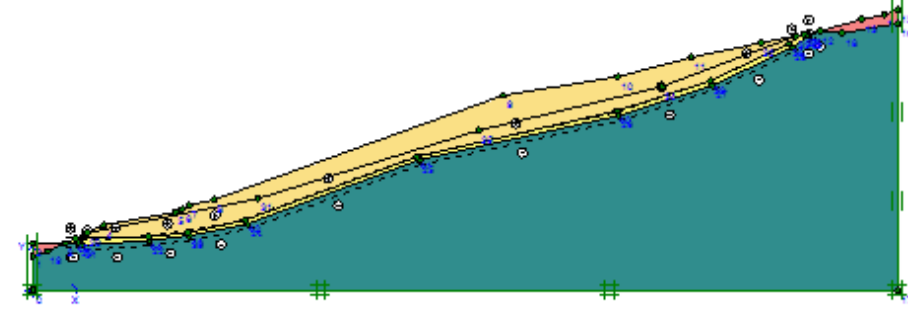
Fig. 5. Slope geometric and the materials layout Geomechanical characteristics of slope